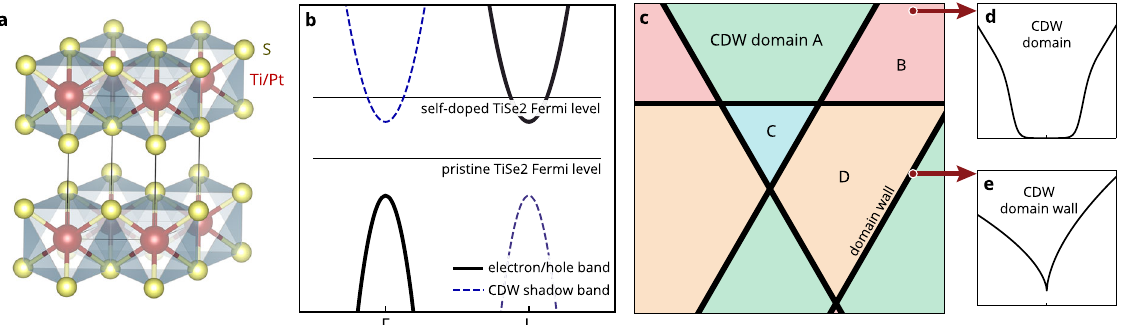
Fig. 1 Crystal structure and schematics. a Crystal structure of 1T-TiSe 2 and location of Pt when substituted. b Schematic band structure of 1T-TiSe 2 with a valence band at the Γ point and a conduction band at the L point. The dashed lines indicate shadow bands due to CDW formation. The as-grown sample is self-doped with the chemical potential within the conduction band. The solid horizontal lines represent the chemical potential for the “ pristine ” system within the gap and the “ self-doped ” system within the conduction band. c Pt substitution for Ti in 1T-TiSe 2 creates domain walls between different charge density wave (CDW) ordered domains. The CDW with ordering wavevector q = L supports at least four types of domains in-plane, related to each other by lattice translations. (Form factor of the CDW may introduce additional types of domains. See, e.g., ref. 73 .) d , e Schematic local density of states based on scanning tunneling spectroscopy results shown in Fig. 4g inside a CDW domain ( d ), showing the semiconducting gap of the pristine 1T-TiSe 2 band structure, and on a CDW domain wall ( e ), showing a pseudogap with power-law behavior.